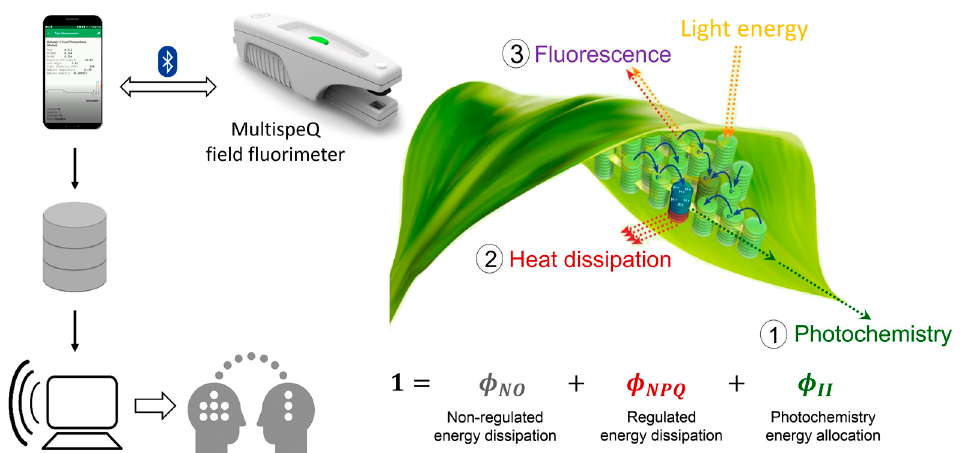
Figure 1. Three competing fates of light energy absorbed by leaf chlorophylls and carotenoids: ( 1 ) photochemistry, ( 2 ) heat dissipation, and ( 3 ) chlorophyll fluorescence. MultispeQ field fluorimeter measures chlorophyll fluorescence in response to light saturating pulses, enabling to estimate the energy proportion allocated towards photochemistry ( φ II ), regulated non-photochemical energy loss ( φ NPQ ), and non-regulated non-photochemical energy loss ( φ NO ). The MultispeQ device is connected via Bluetooth with the Photosynq app installed on a smartphone. The data collected in the field is sent to the cloud, then the users can use analysis tools, discuss and share the data in the web interface.